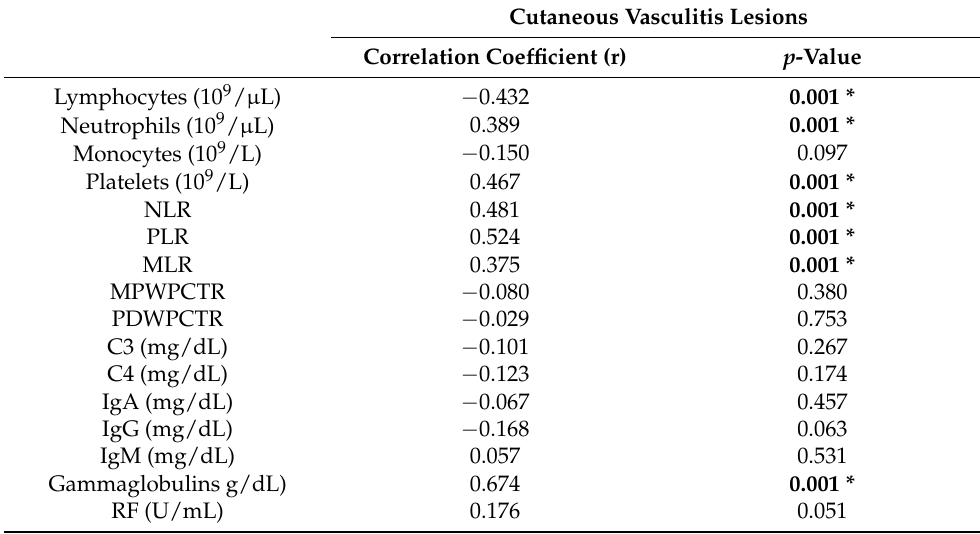
Table 3. Correlation between hematological parameters and cutaneous vasculitis